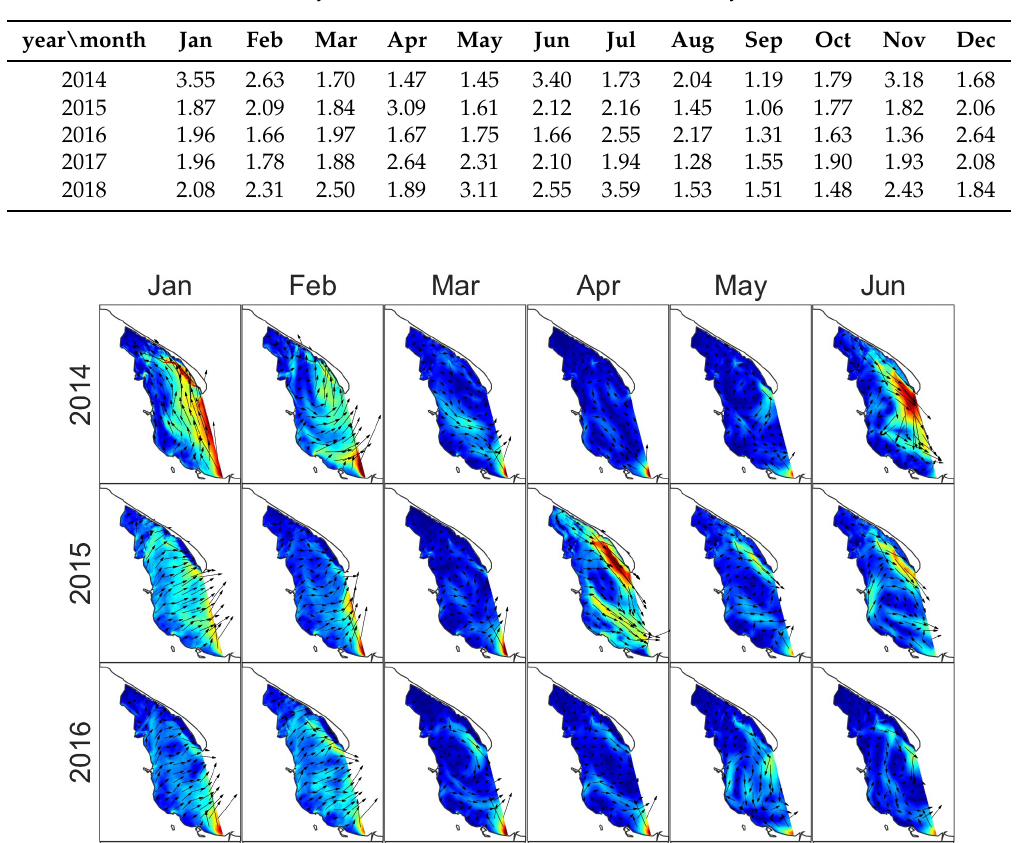
Table A15. Monthly standard deviations for currents for the years 2014–2018.